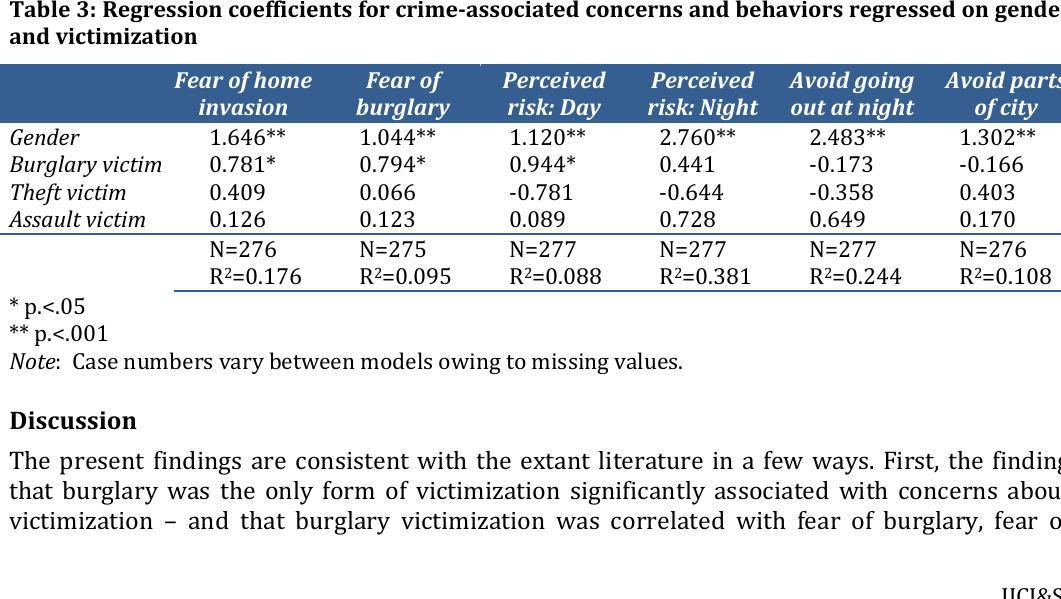
Table 3: Regression coefficients for crime ‐ associated concerns and behaviors regressed on gender and victimization Fear of home Fear of Perceived Perceived Avoid going Avoid parts invasion burglary risk: Day risk: Night out at night of city Gender